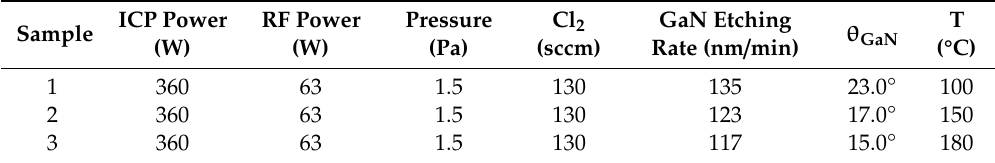
Table 2. Etched results with di ff erent hard baking temperatures.